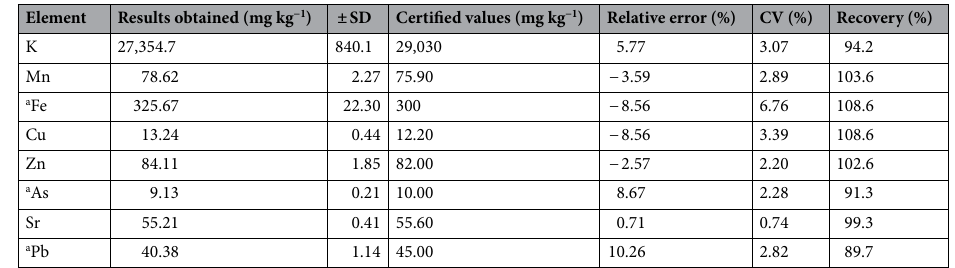
Table 2. Comparison of measurement and certified values (mg kg −1 , dry weight of CRM Spinach/NIST 1570a. a Certified reference material Orchard leaf/NIST